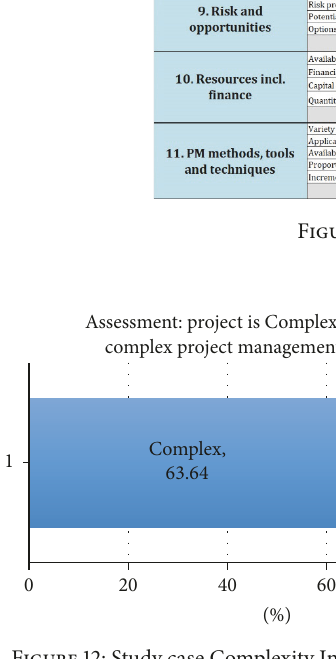
Figure 12: Study case Complexity Index score for